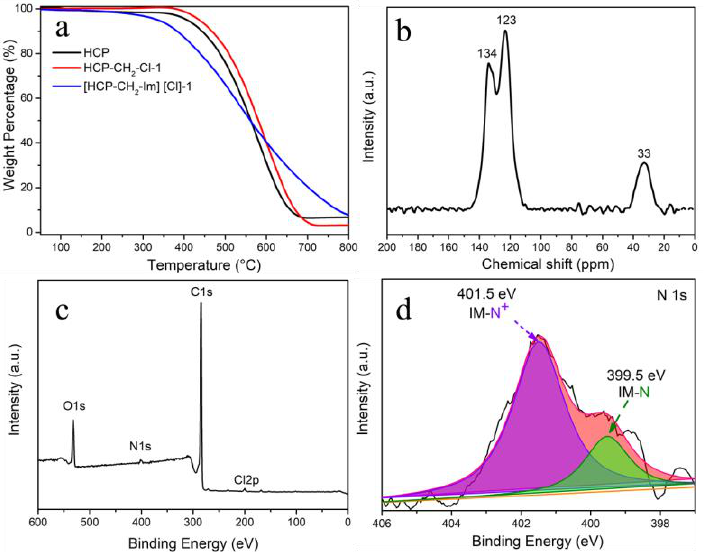
Figure 3. ( a ) TGA curves of HCP, HCP-CH 2 -Cl-1, and [HCP-CH 2 -Im][Cl]-1, ( b ) 13 C CP/MAS NMR spectrum of [HCP-CH 2 -Im][Cl]-1, ( c ) survey scan, and ( d ) N 1 s XPS spectra of [HCP-CH 2 -Im][Cl]-1.